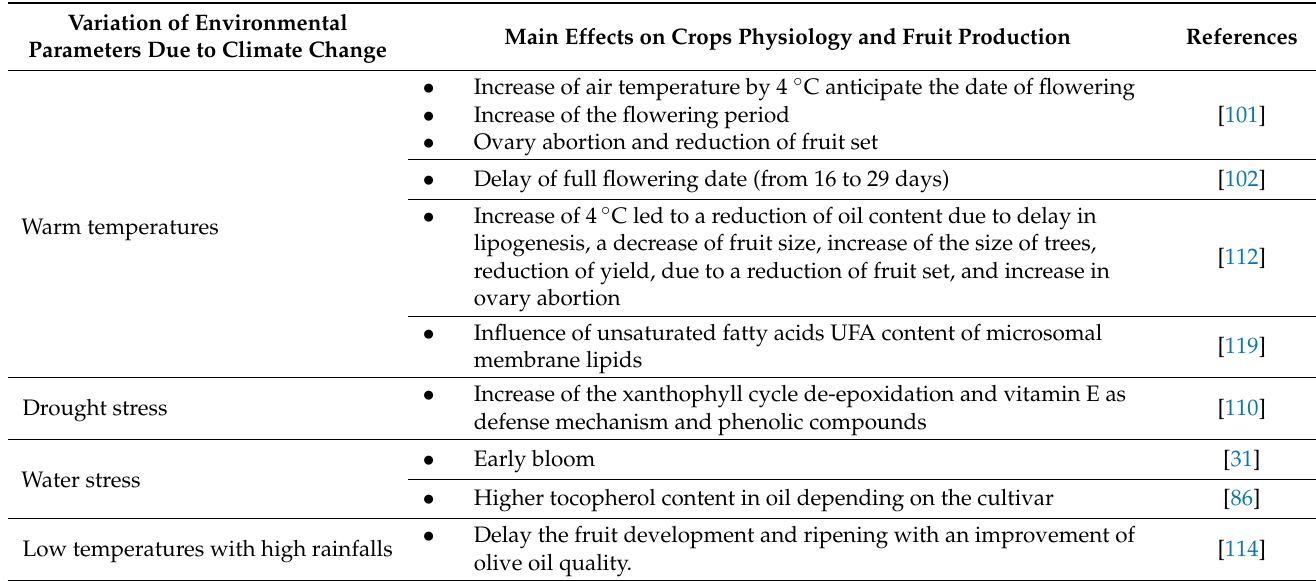
Table 2. Summary of principal effects of environmental conditions variation on olive